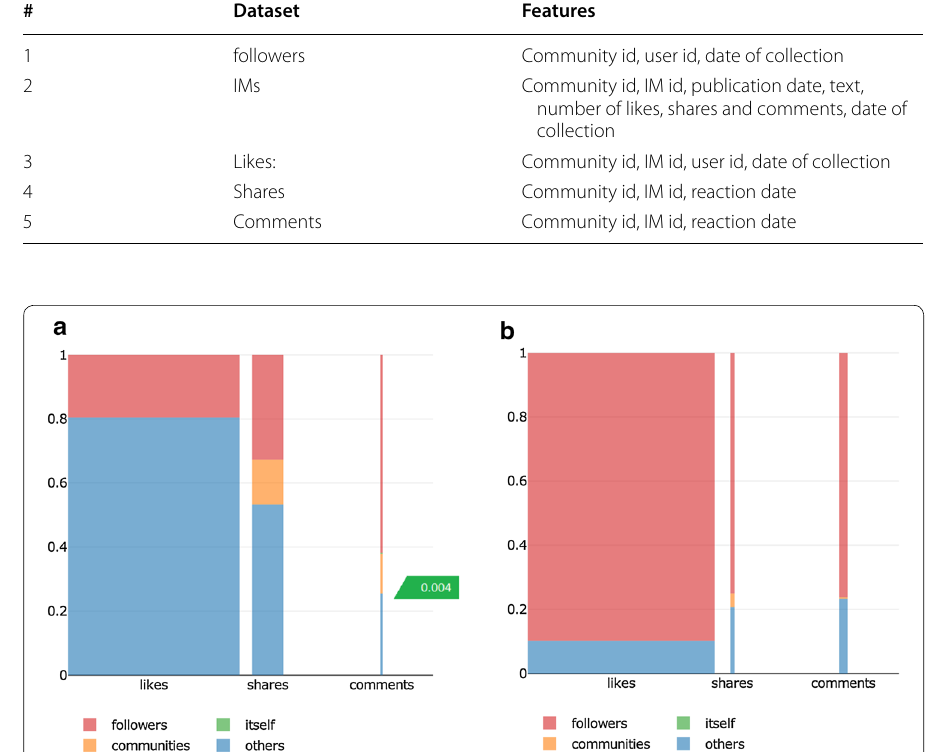
Fig. 2 Parts of different types of reactions for communities: a network charity, b news. The width of the rectangle shows the proportion of the reaction of this type, the height of the rectangle shows the proportion of reactions from various